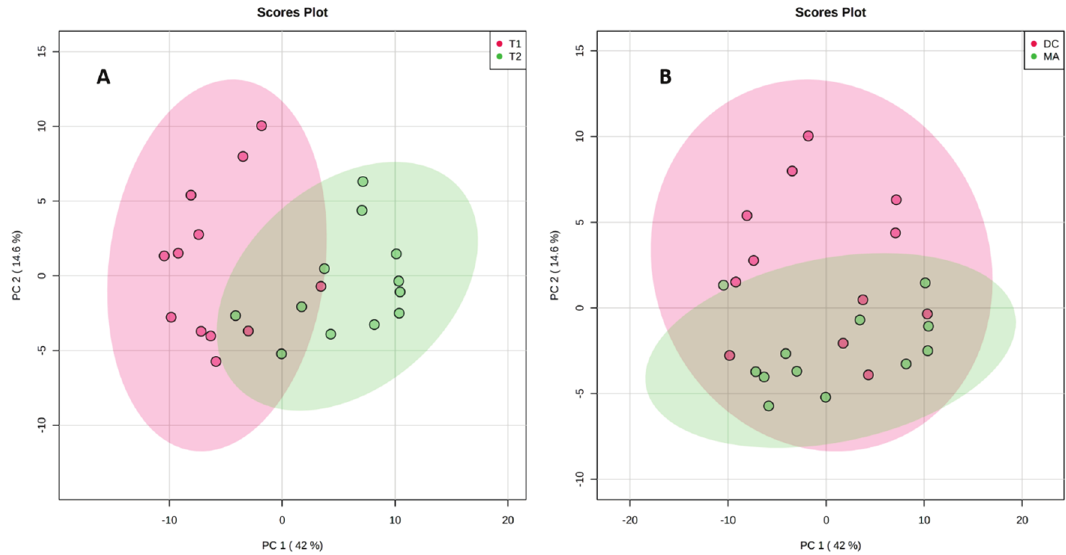
Figure 2. Principal component analysis (PCA) on the metabolomic profiles of all samples ( A ) before (T1) and after the rainy event (T2) and ( B ) according to the substrate macroalga (MA) or dead corals (DC).